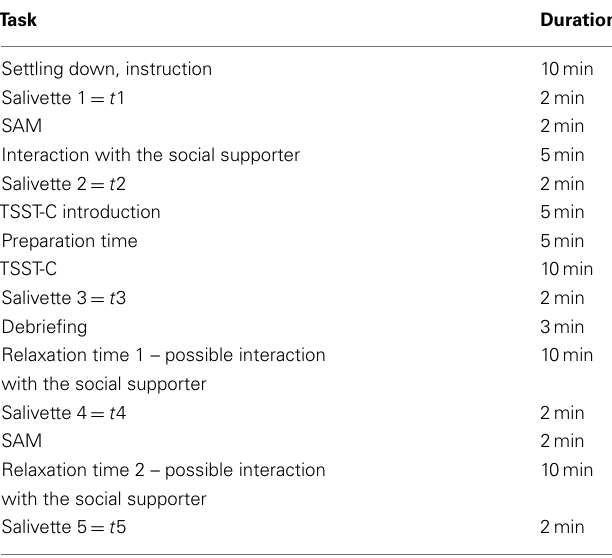
Table 1 | Procedures during the trier social stress test for children